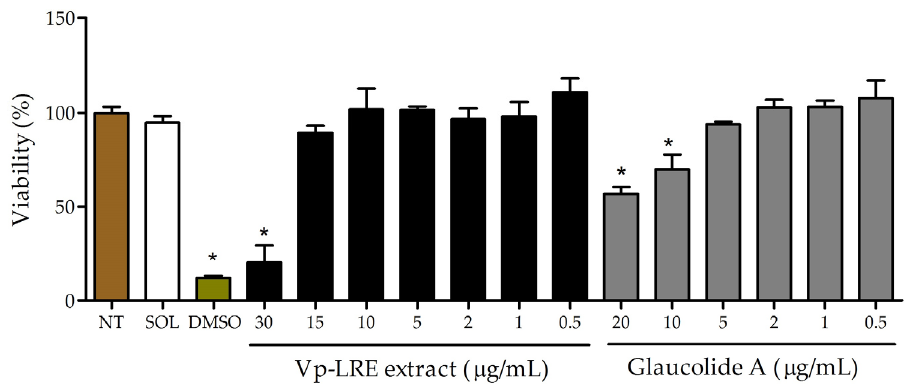
Figure 3. Evaluation of the cytotoxicity of V. polyanthes leaf rinse extract (Vp-LRE) and glaucolide A on RAW 264.7 cell line. Cell viability was evaluated via MTT assay and expressed as mean ± SD relative to untreated control (NT) (* p < 0.05 vs. NT).